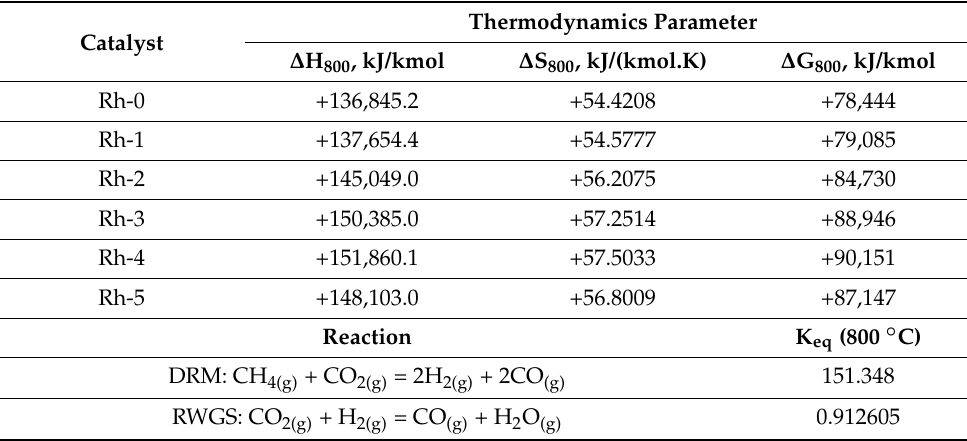
Table 5. Calculated thermodynamic parameter over the various catalysts at 800 ◦ C. Thermodynamics Catalyst